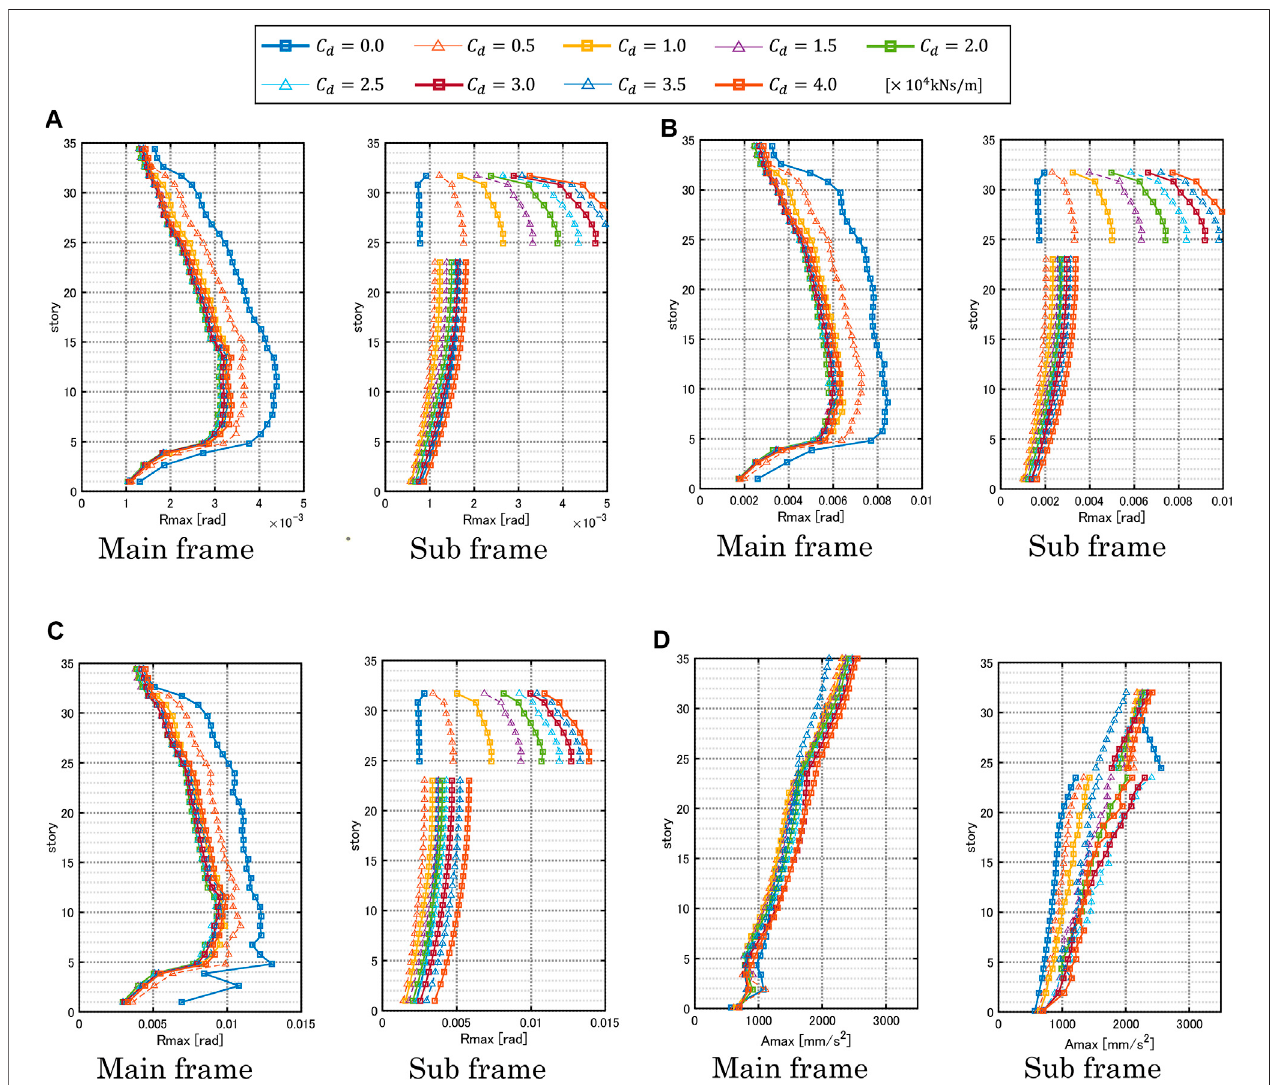
FIGURE 12 | Maximum interstory drift angle under critical multi impulse and maximum acceleration under equivalent 5-cycle sinusoidal wave for various damper quantities, (A) Maximum interstory drift angle for V MI (cid:1) 0 . 20 [ m / s ] , (B) Maximum interstory drift angle for V MI (cid:1) 0 . 40 [ m / s ] , (C) Maximum interstory drift angle for V MI (cid:1) 0 . 60 [ m / s ] , (D) Maximum acceleration for 5-cycle sinusoidal wave equivalent to V MI (cid:1) 0 . 60 [ m / s ] .